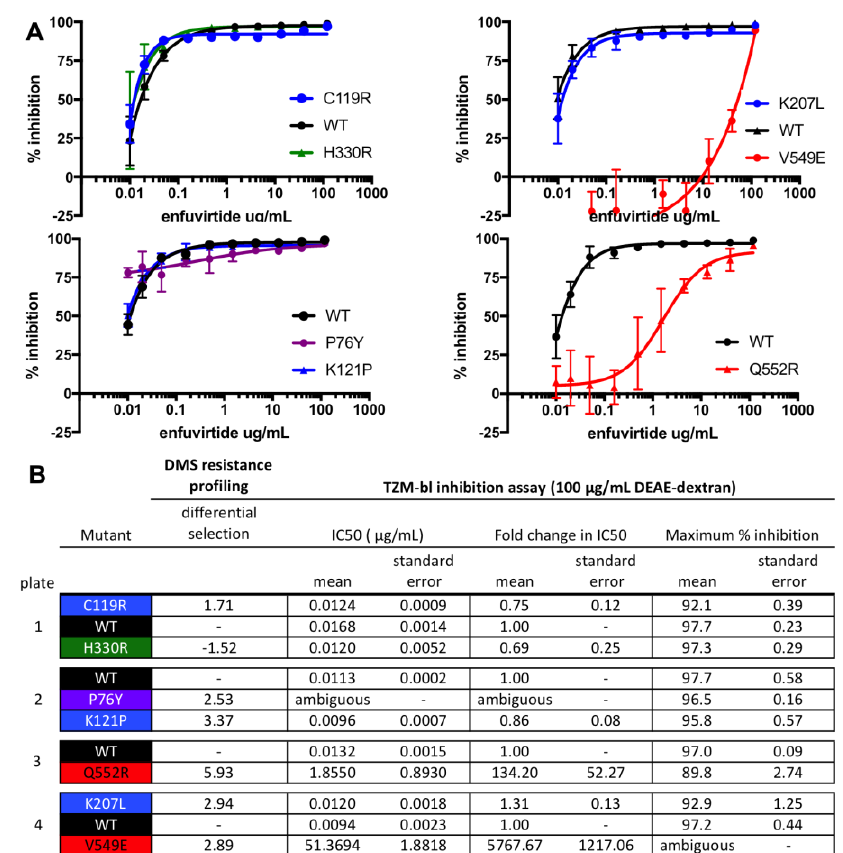
Figure 3. Validation of enfuvirtide resistance mutants using a TZM-bl inhibition assay. TZM-bl inhibition assays were performed in the presence of 100 µ g / mL DEAE-dextran, similar to the resistance profiling. ( A ) Inhibition curves are the average of two biological replicates, each performed in duplicate. ( B ) The IC 50 , the fold change in IC 50 relative to wildtype (WT), and the maximum percent inhibition for each mutant, determined from the fit four-parameter logistic curves. WT virus was run on each plate, and each mutant virus curve was compared to the plate internal WT control. The standard error of the mean is also shown. H330R, which was not enriched in the resistance profiling, was included as a control. In ( A , B ), mutant pseudoviruses are colored according to groups (black: WT; green: control mutant not expected to a ff ect enfuvirtide sensitivity; blue: mutants in the V1 / V2 Stem / co-receptor binding site; red: mutants in / near NHR binding site).